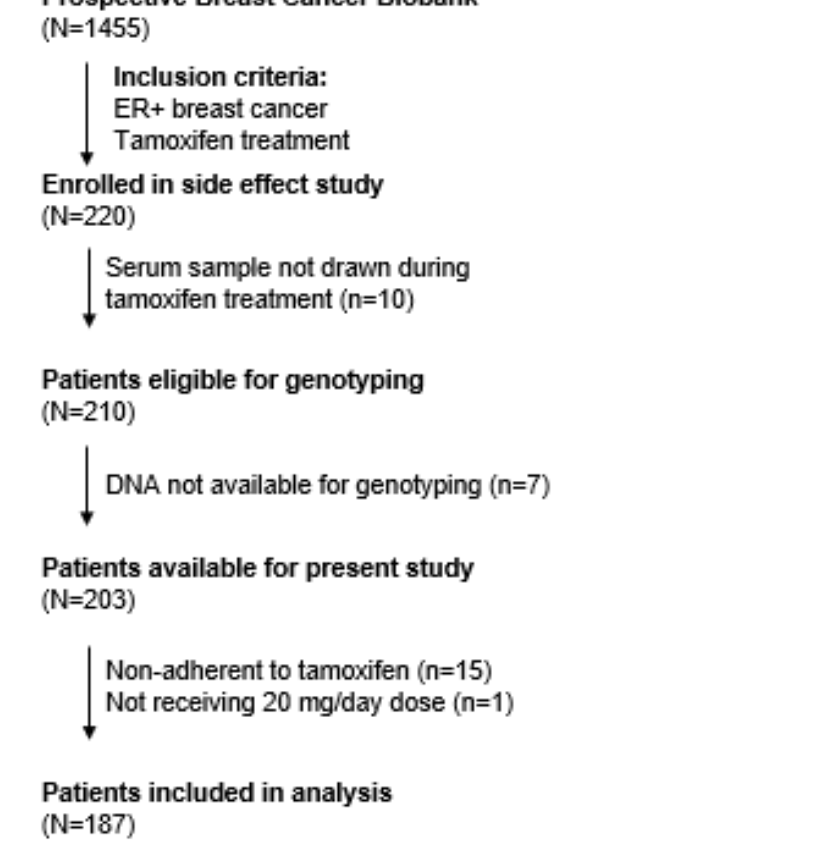
Figure 1. Patient flow from original cohort into present study. PROM = Patient Reported Outcomes. Non-adherence was determined by pharmacokinetic tamoxifen cut off 40